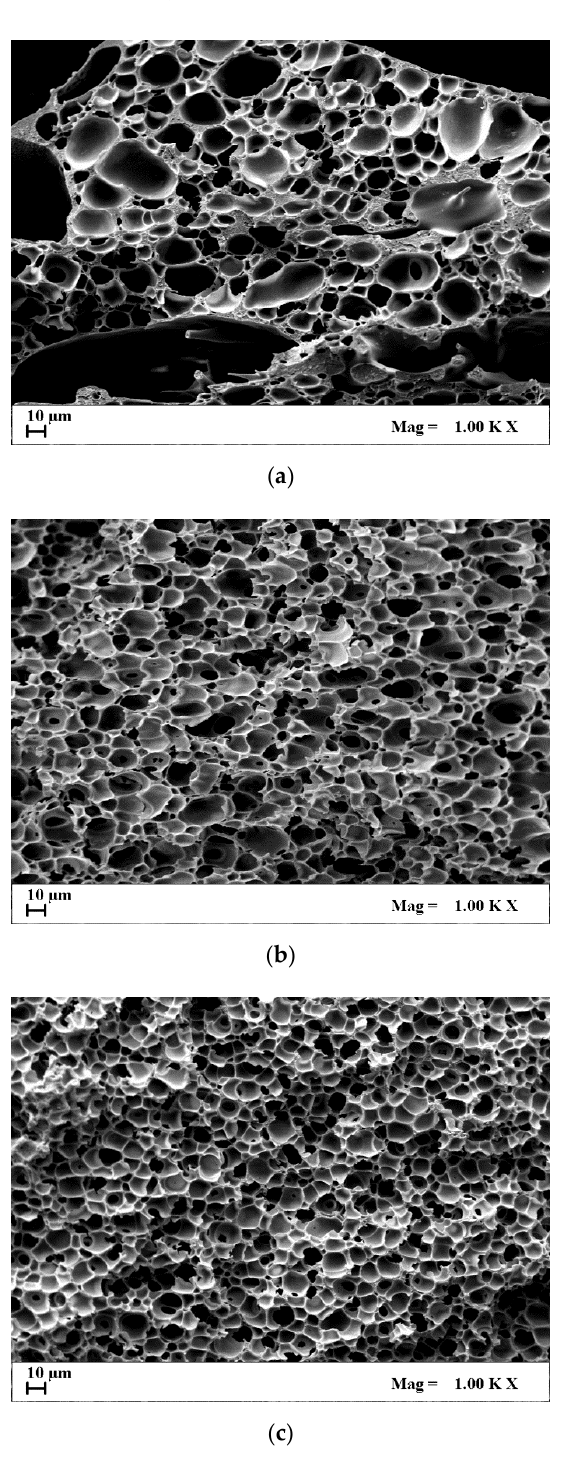
Figure 2. SEM images of AgNO 3 -loaded CA membranes, produced at 200 bar and 45 °C: ( a ) 15%(w/w) CA, ( b ) 20%(w/w) CA, ( c ) 30%(w/w) CA. Table 1. Mean pore size and porosity of all the CA membranes loaded with AgNO 3 , produced in this work.